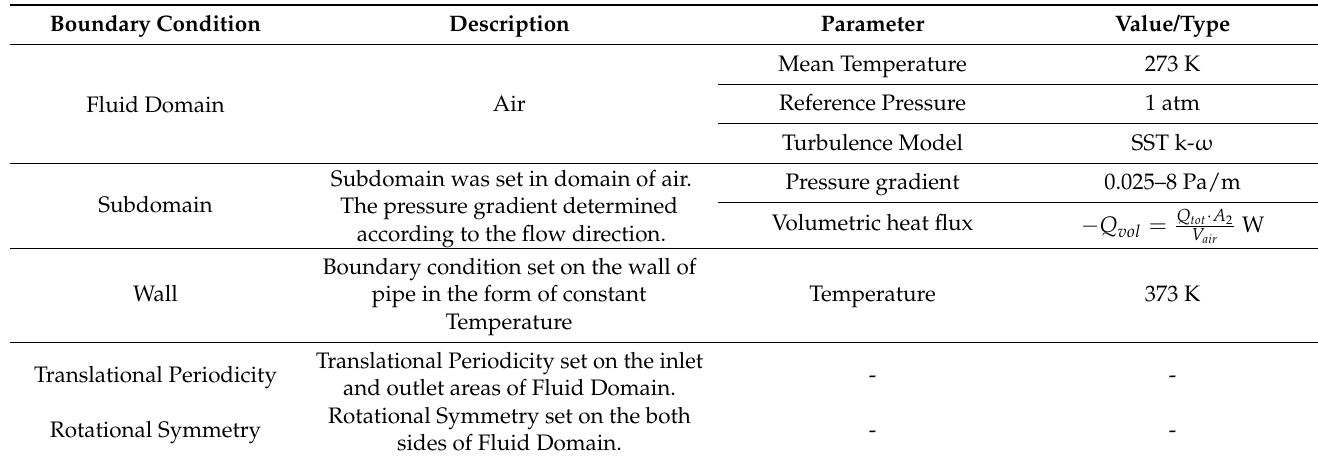
Table 1. Boundary conditions and the parameters values.